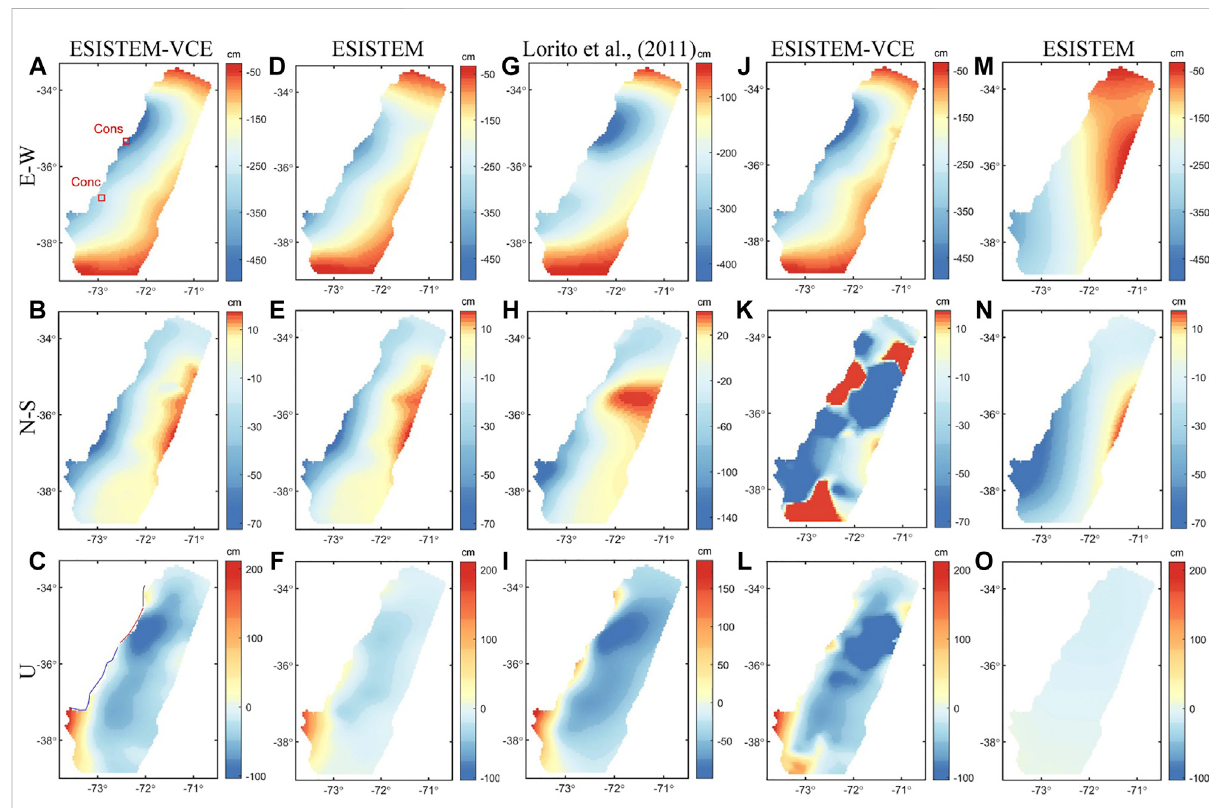
Three-dimensionalsurfacedisplacement fi eldderivedfromdifferentdatasources. (A – C) Three-dimensionalsurfacedisplacement fi eldderived from the ESISTEM-VCE method with all data. In (A) , the red rectangles denote the locations of surrounding cities. (D – F) Three-dimensional surface displacement fi eld derived from the ESISTEM method with all data. (G – I) Three-dimensional displacement fi eld from forward modeling with the slip distributionmodelfromLoritoetal.(2011). (J – L) Three-dimensionaldisplacement fi